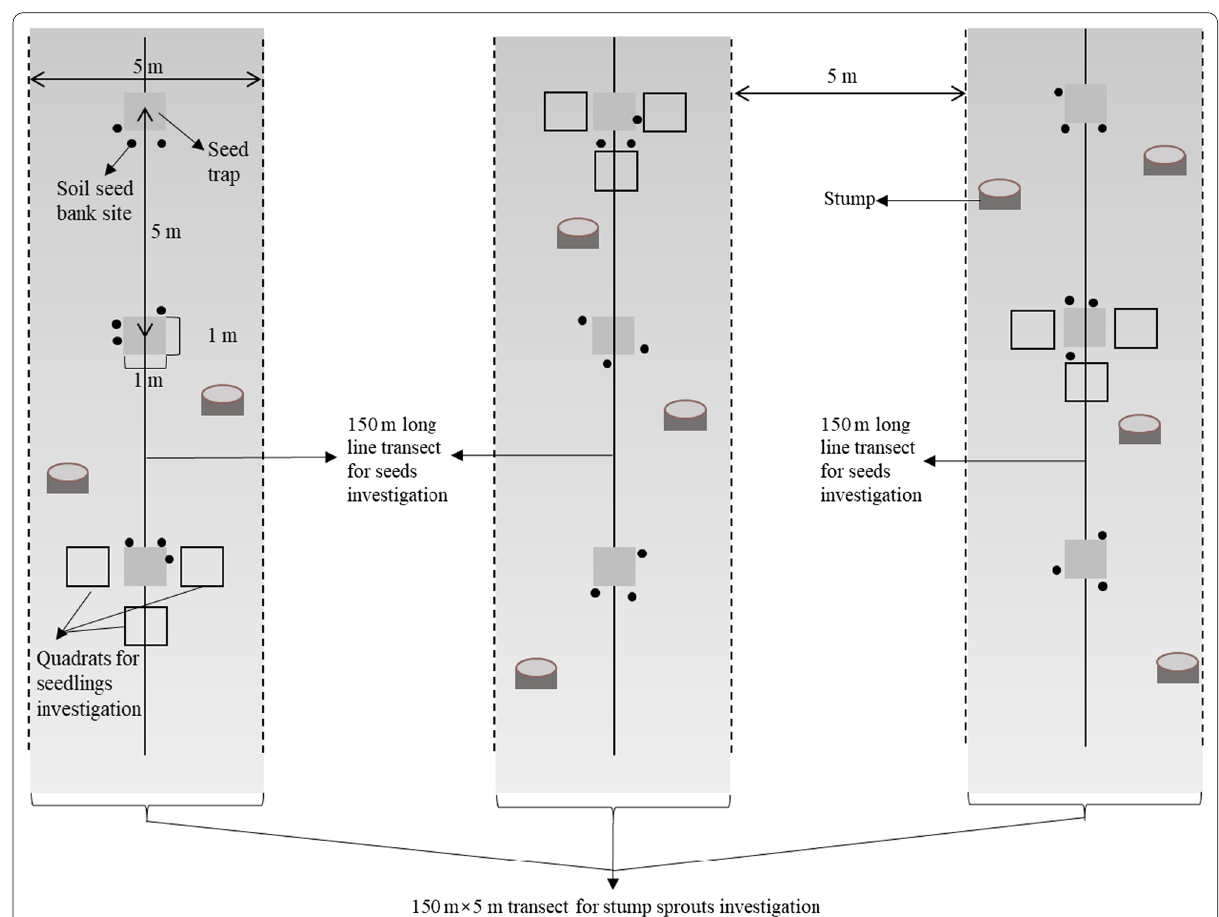
Fig. 1 Sketch map of seed rain, soil seed bank, seedling and sprout investigation of dominant woody species within each stand of secondary